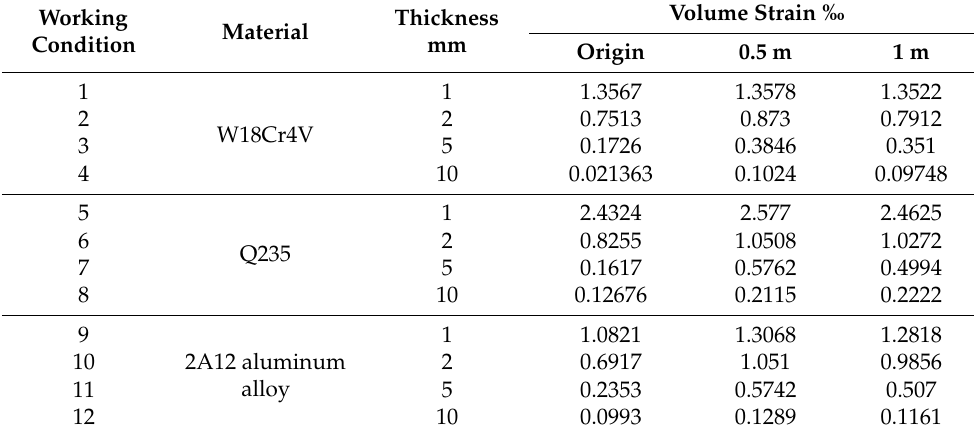
Table 4. Thermal deformation analysis results of different working